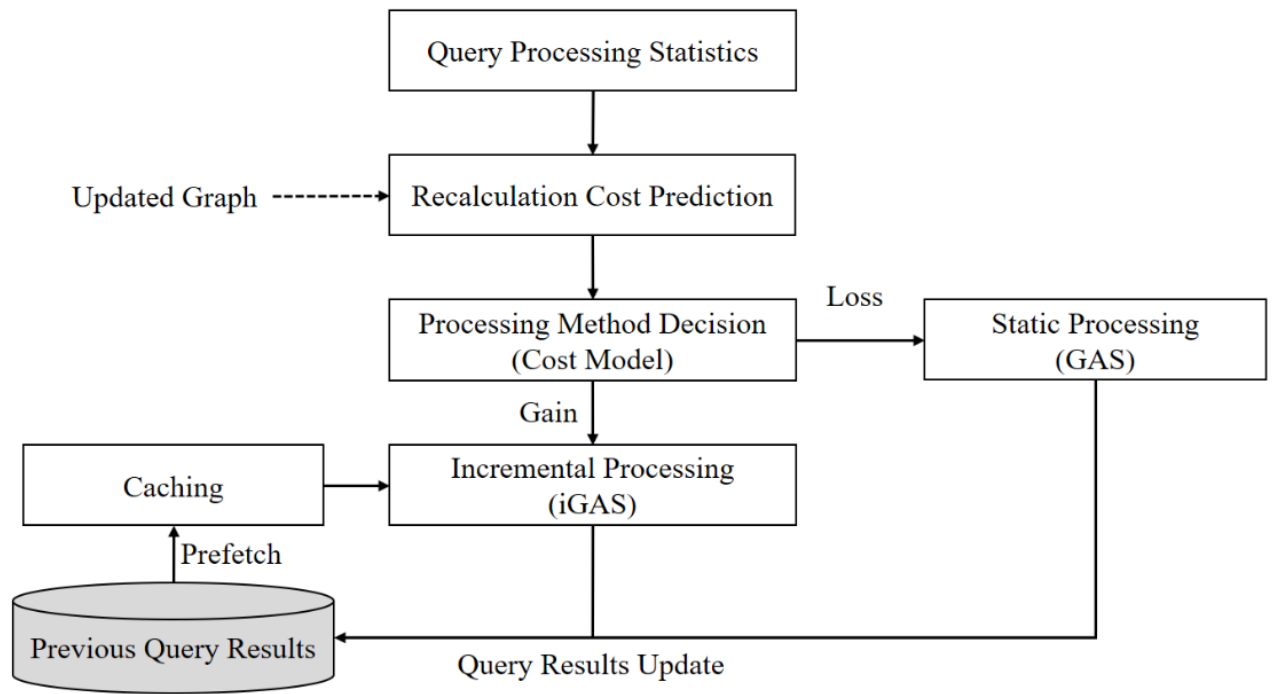
Figure 1. Overall procedure of the proposed scheme.